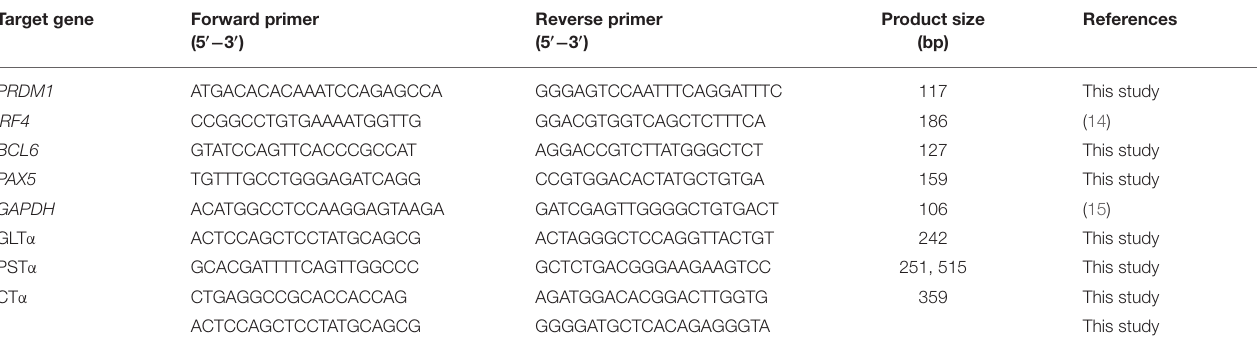
TABLE 1 | The sequence of the primers used for PCR in this study. Target